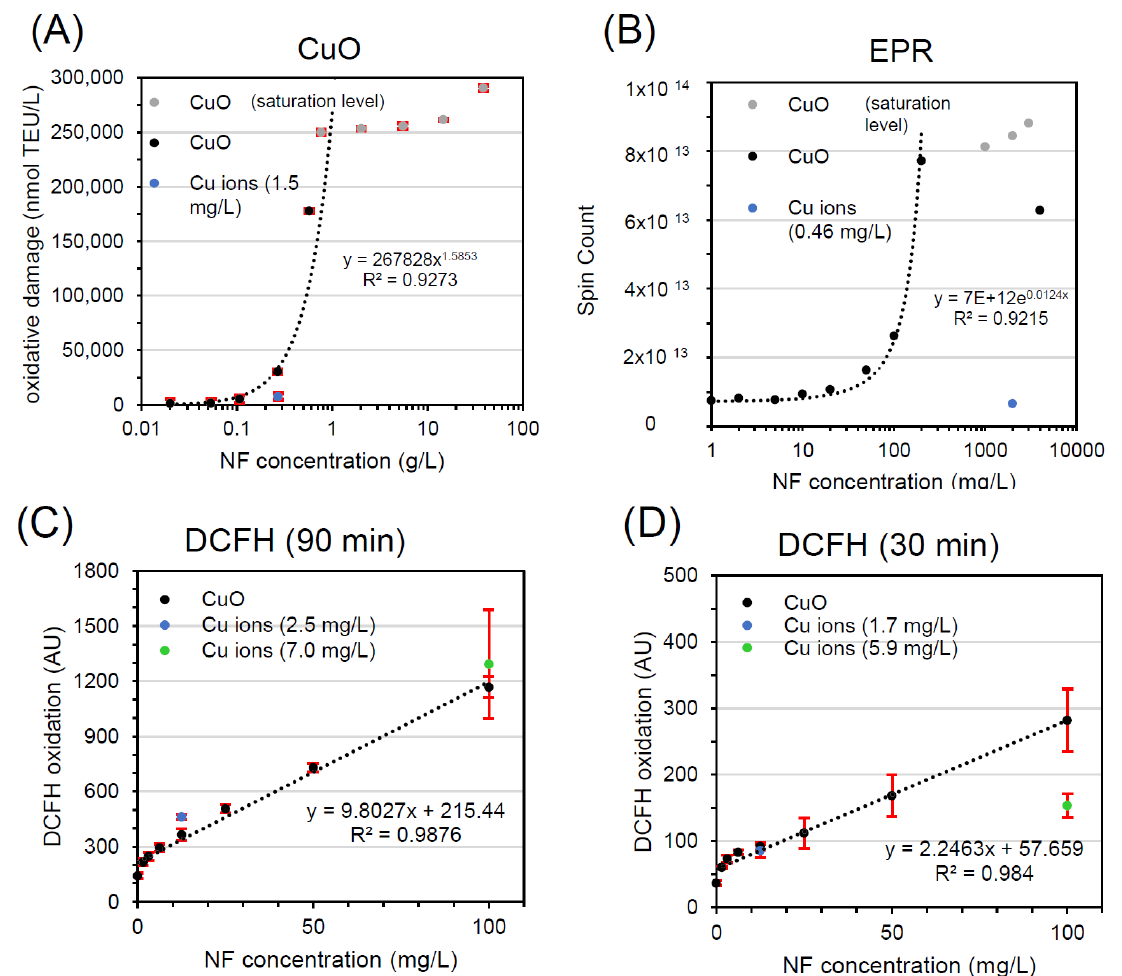
Figure 3. Workflow implementation with FRAS ( A ), EPR ( B ), DCFH 2 -DA ( C , D ) testing CuO NF and ion reactivity. All curves represent dose-response data of particles (black, grey) and of ions concentration (blue, green). TEU, Trolox equivalent unit (mM); AU, arbitrary unit.